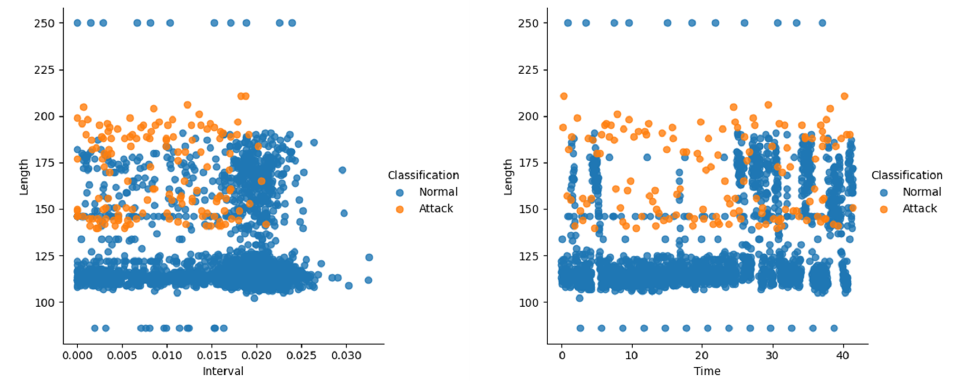
Figure 5. 2D scatter of Linear Interpolation Spreading based attack with only small